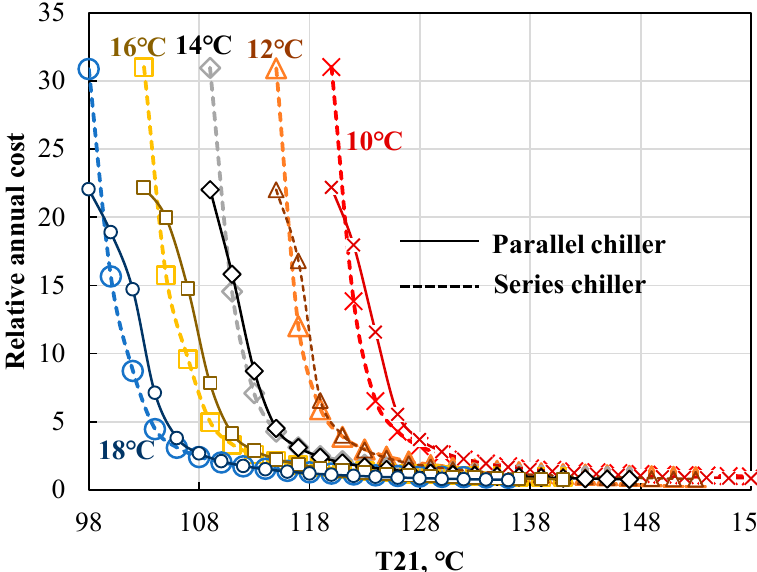
Figure 10. Variation of the annual cost with the two types of absorption chillers as function of chilled water temperature and steam temperature (T21).